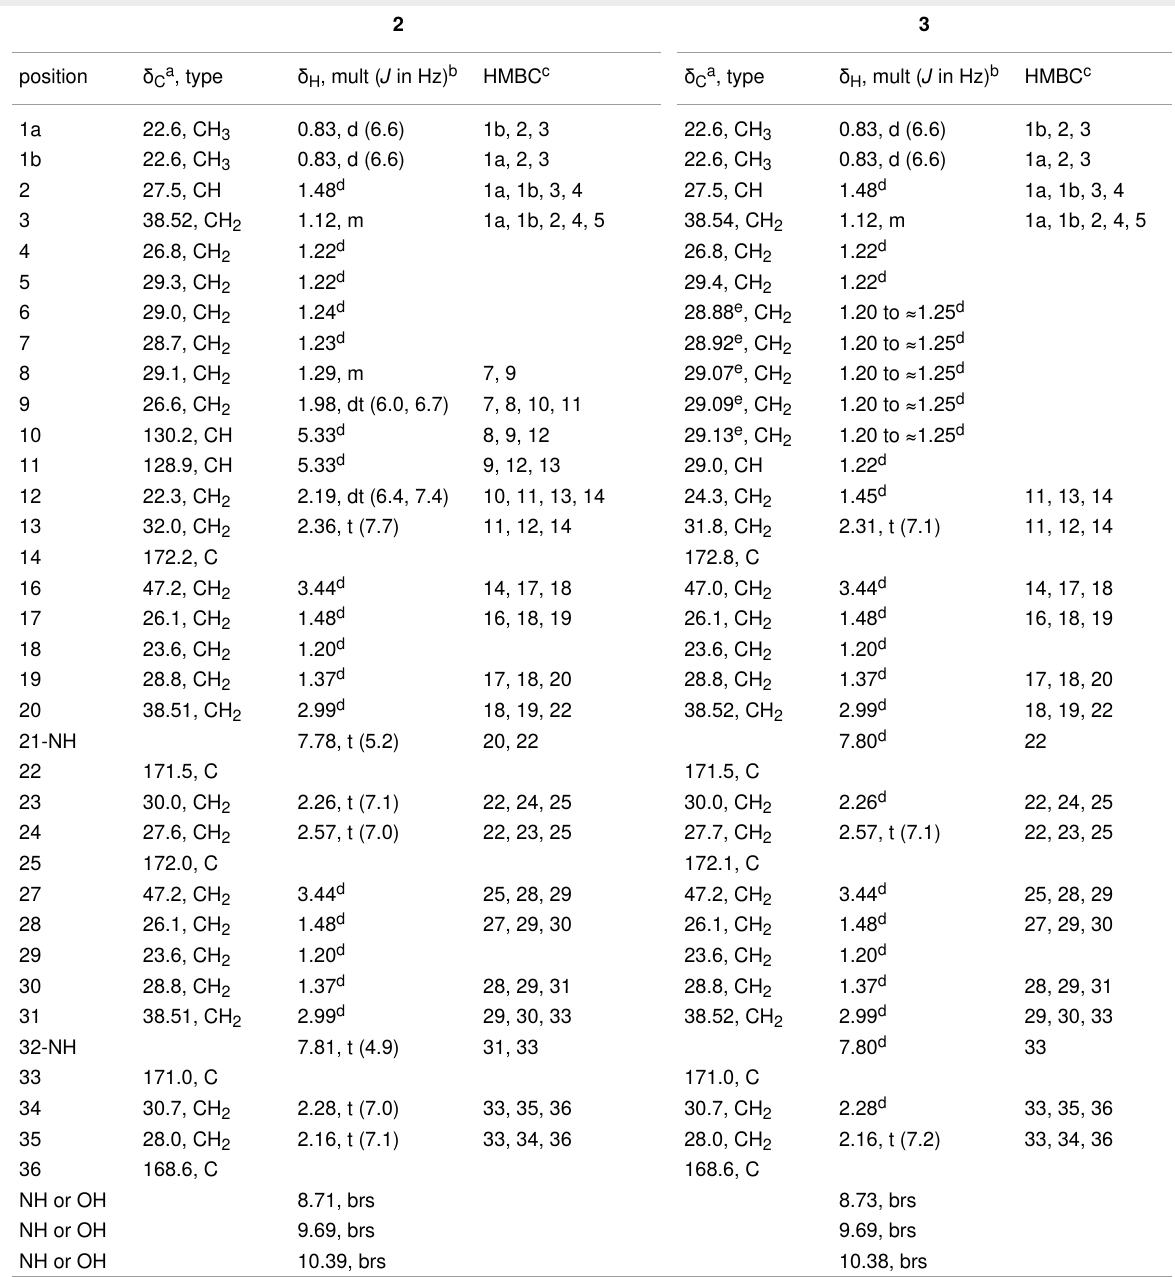
Table 2: 1 H and 13 C NMR data for tenacibactins L ( 2 ) and M ( 3 ) in DMSO- d 6 .